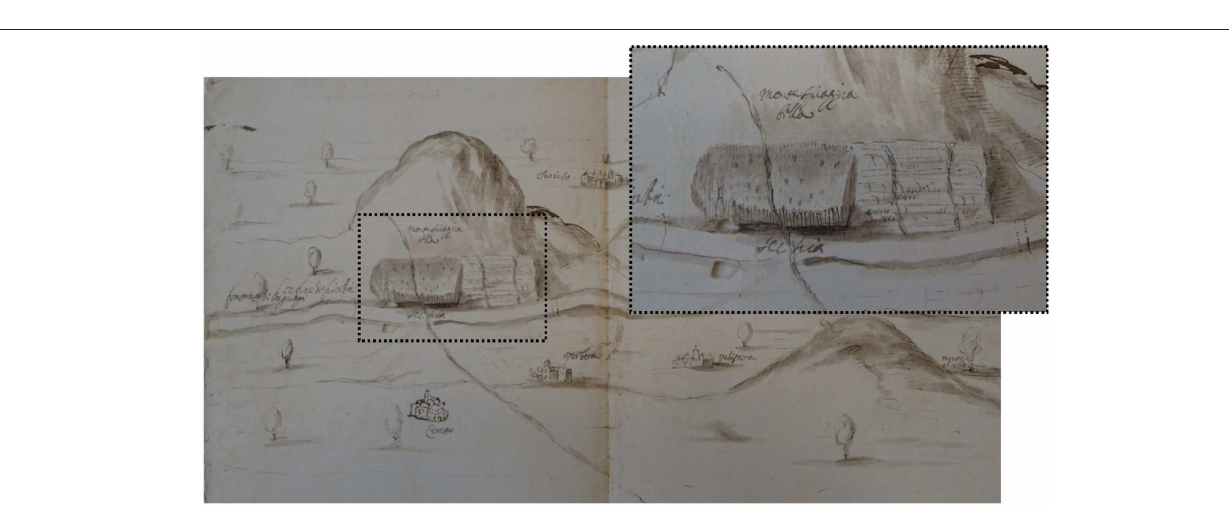
FIGURE 9 | ASP. Confini, B205/8, dis. 900. Upper Secchia valley: detail of an anonymous manuscript map; half 17th c.